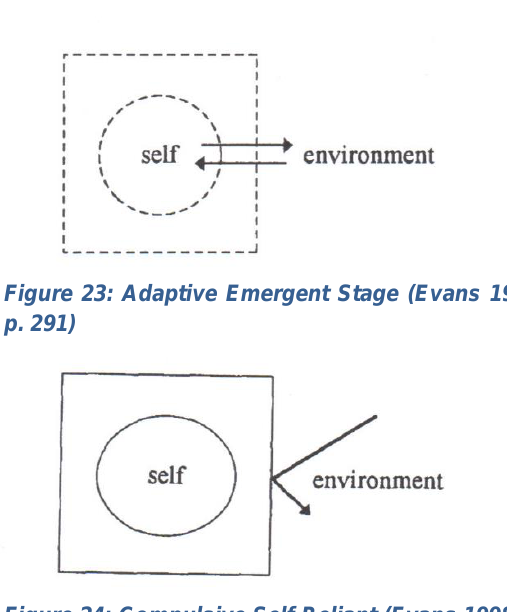
Figure 24: Compulsive Self-Reliant (Evans 1998 p. 292)